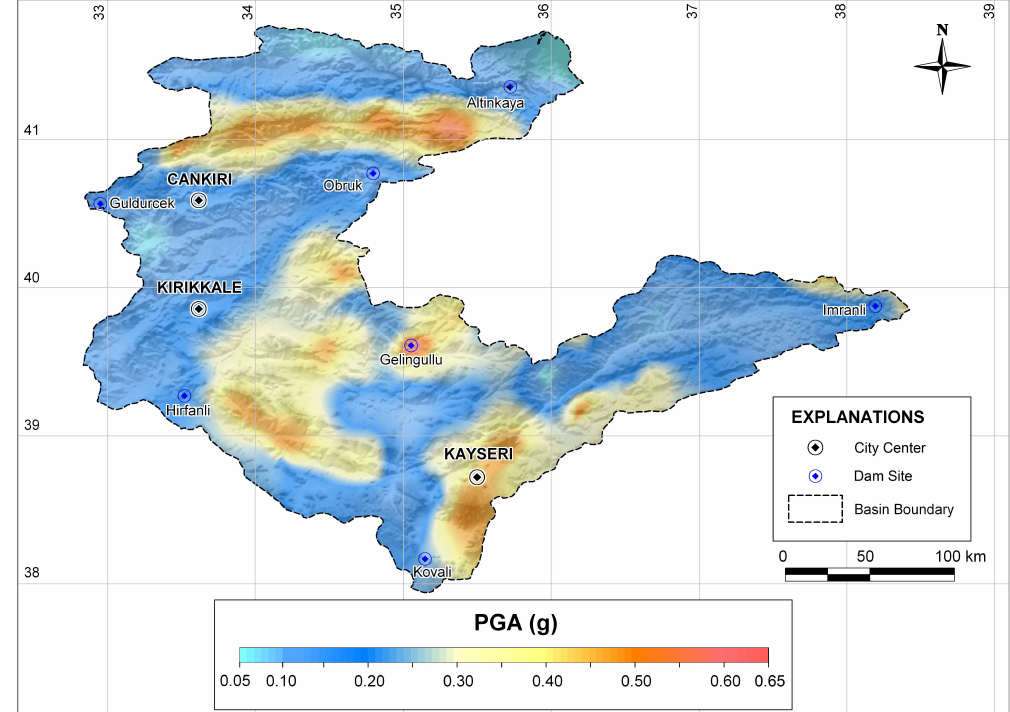
Fig. 4. Seismic hazard map of the Kizilirmak Basin as based on maximum design earthquake which represents a dam site.